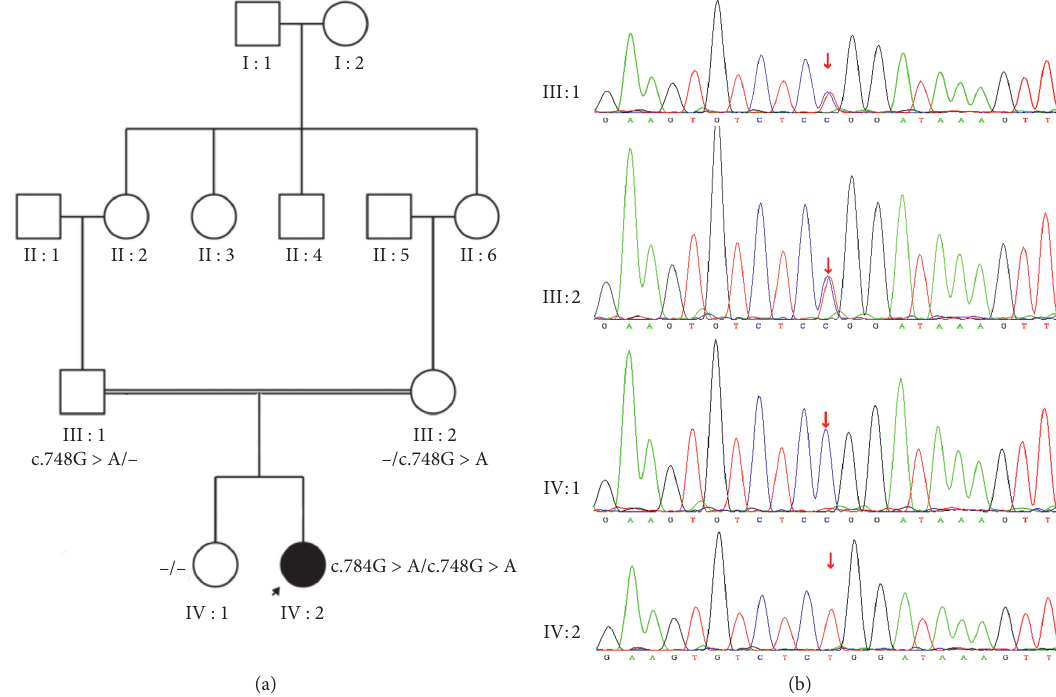
Figure 3: The pedigree and DNA sequencing of family B (a). The pedigree of family B.(b) III:1 and III: 2 had a heterozygous c.748G > A variant in the MKKS gene, IV :1 had none of the mutant allele, and proband IV :2 had a homozygous c.748G > A